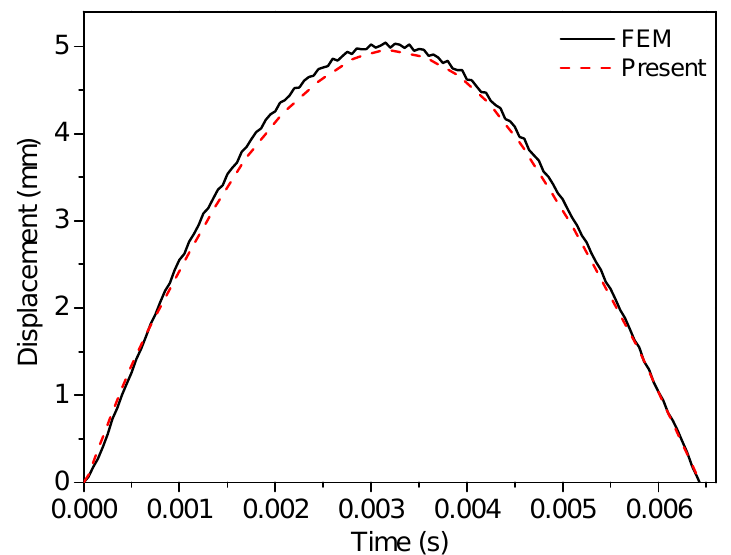
Figure 7. Comparison of the plate center displacement with the results obtained from FEM and present